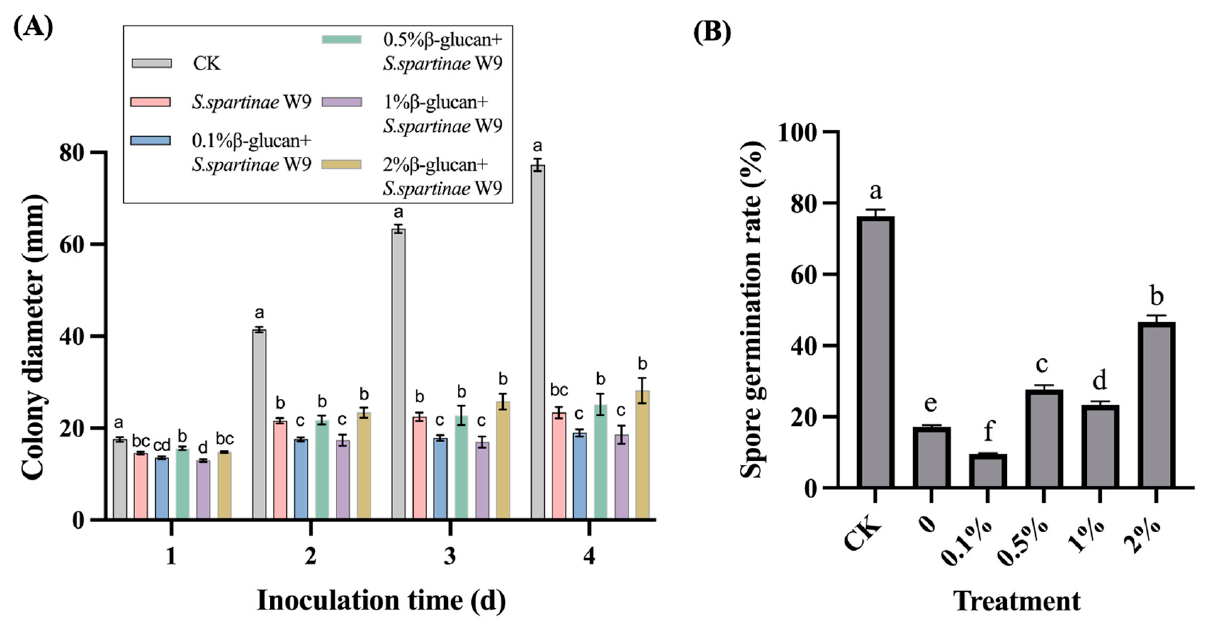
Figure 2. In vitro inhibition of S. spartinae W9 cultured with different concentrations of β -glucan against B. cinerea. ( A ) Mycelia diameter of B. cinere after treatment with S. spartinae W9 cultured with different concentrations (0, 0.1%, 0.5%, 1%, and 2%) of β -glucan. ( B ) Spore germination rate of B. cinerea after treatment with S. spartinae W9 cultured with different concentrations (0, 0.1%, 0.5%, 1%, and 2%) of β -glucan. Different lowercase letters indicated significant differences between different treatment groups according to Duncan’s test ( p < 0.05).